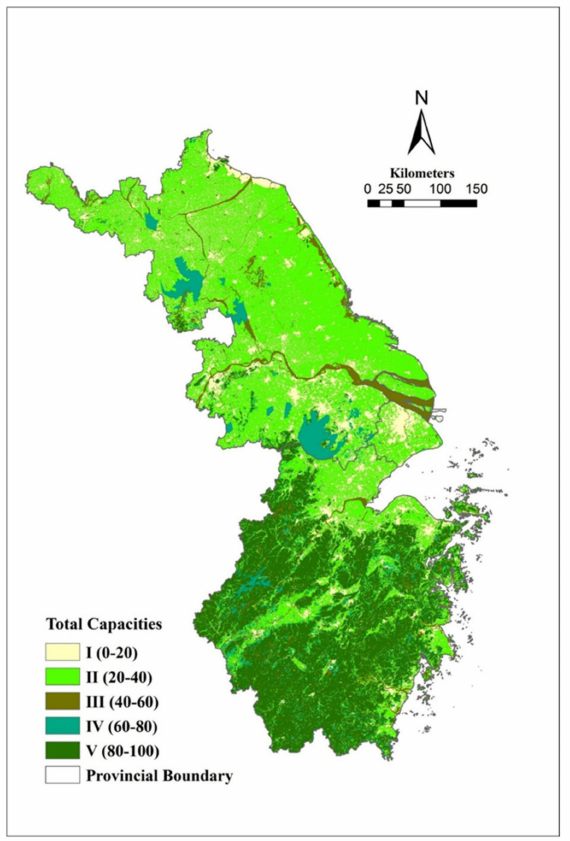
Figure 3. Spatial pattern and levels of total capacities of ES of Yangtze River Delta (YRD). Level V and Level II accounted for 27.44% and 47.12% of the total area, respectively. Among the five levels, Level II occupied the largest area of the region. Level I and Level IV had patchy patterns in the region and clustered in the middle of the region. Level I and IV accounted for 13.24% and 5.48% of the total area, respectively. Level III had